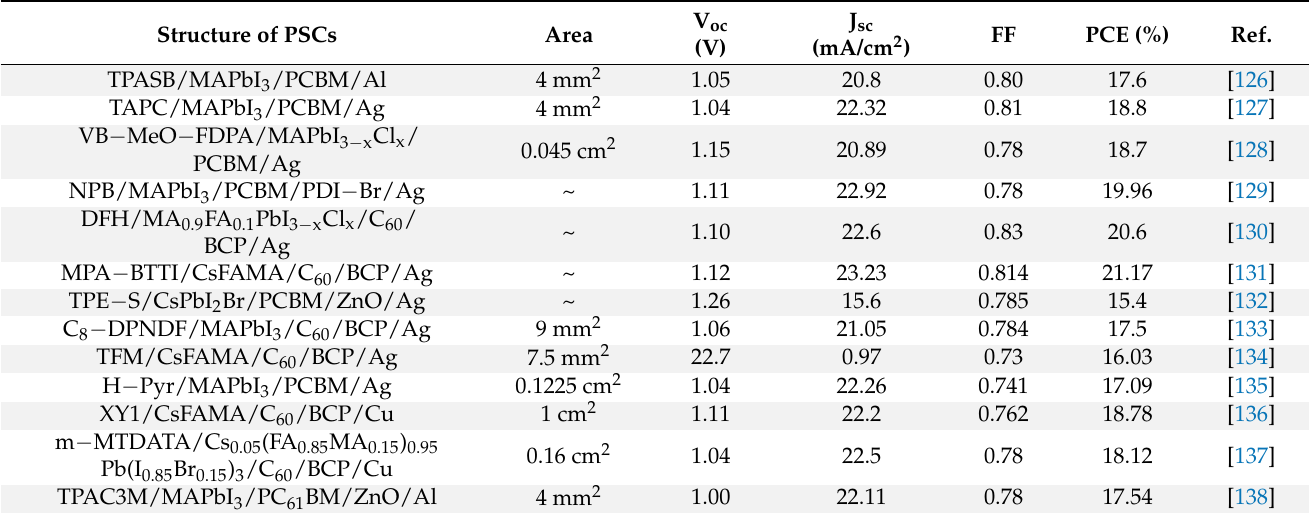
Table 11. Performances of several representative inverted PSCs on the basis of organic small − molecule